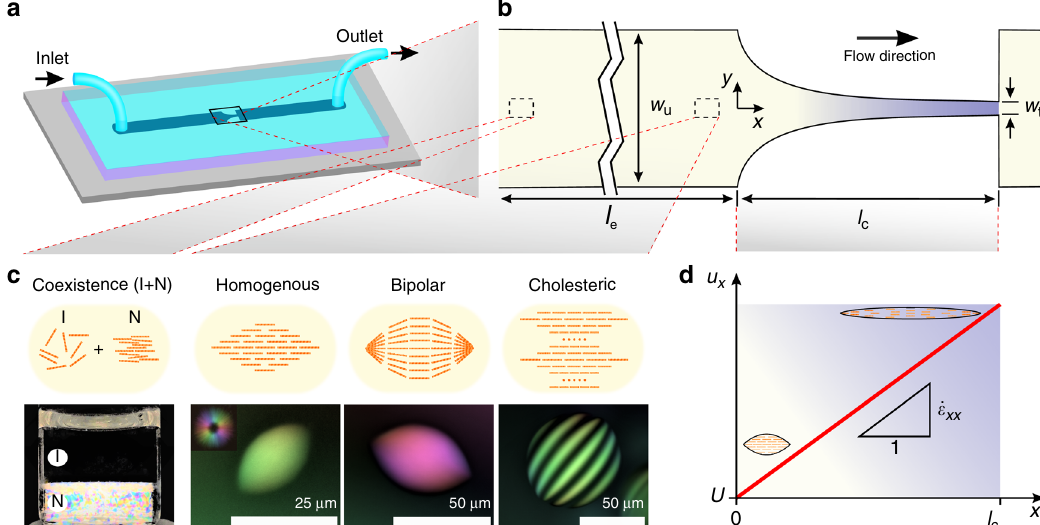
Fig. 1 Micro fl uidic chip to expose different classes of tactoids to extensional fl ow. a Schematic of the micro fl uidic chip. b The hyperbolic contraction geometry. The origin of the coordinate system is located at the contraction inlet with x axis along the channel centerline. c A suspension of amyloid fi brils at concertation in the isotropic (I) + nematic (N) coexistence region is injected to the micro fl uidic chip. LC (liquid crystal)-PolScope images of the three classes of homogenous, bipolar, and cholesteric tactoids studied. d Schematic plot of the average velocity of fl ow, that varies linearly along the contraction zone to allow a constant extension rate ( _ ε xx ). The term U denotes the fl ow speed in the straight channel before and after contraction